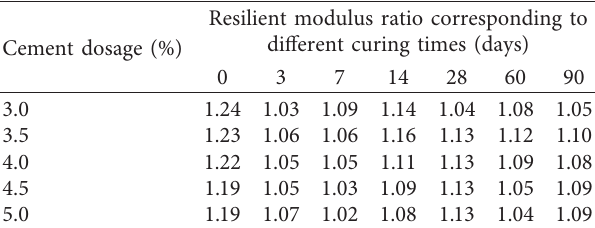
Table 11: Resilient modulus ratio of the CSCG in the case of GM and XM